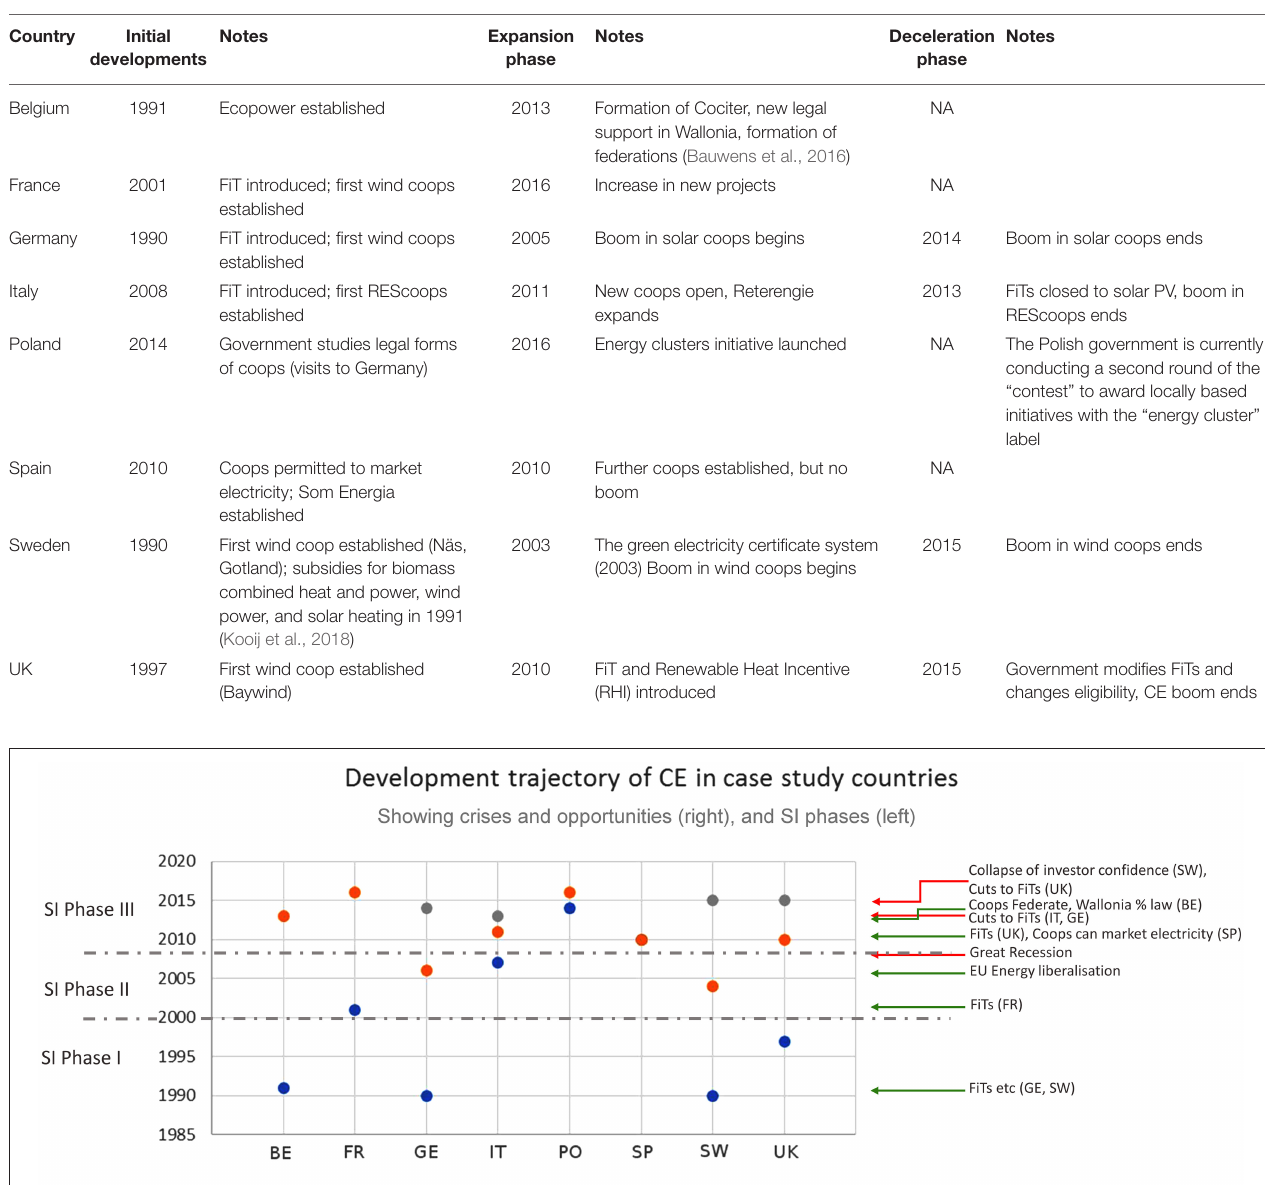
TABLE 2 | Timeline of main developments in CE. Country